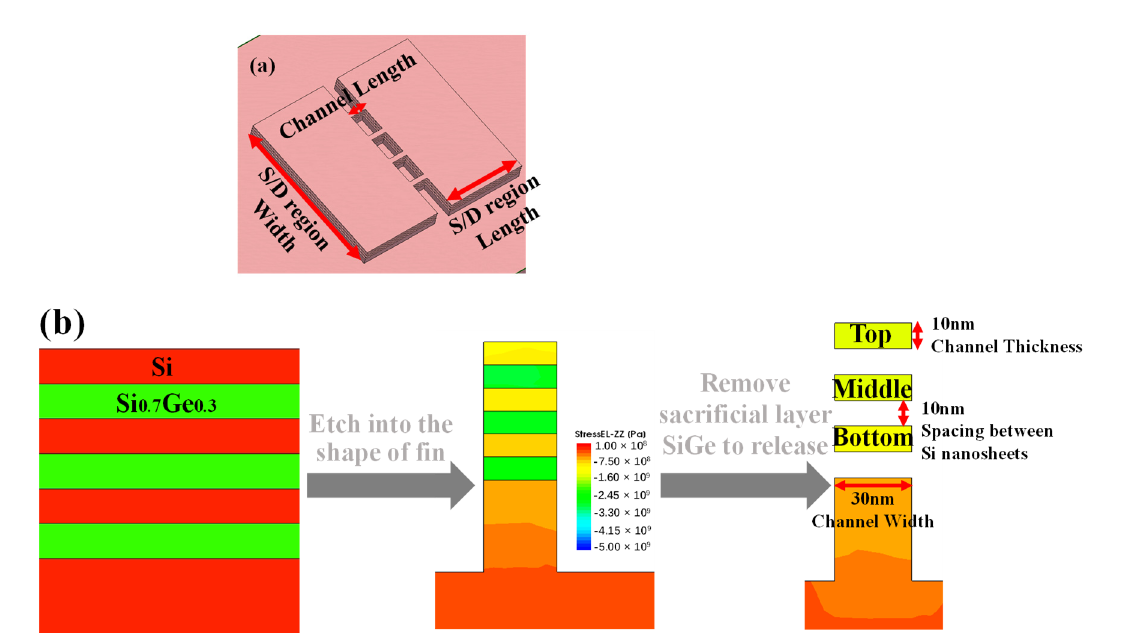
Figure 3. ( a ) The top view of the simulated three-layer stacked nanosheets transistor schematic; ( b ) cross-sectional view of stress distribution under different process steps in Sentaurus.